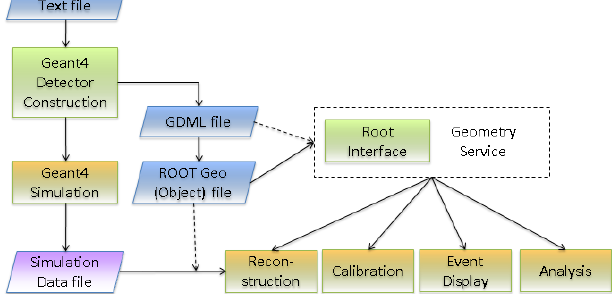
Fig.5. GDML-based geometry management in offline